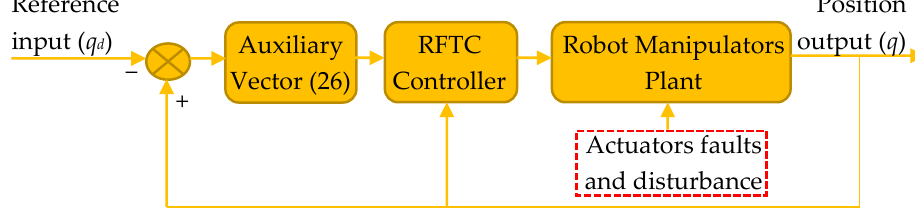
Figure 9. RFTC with auxiliary vector